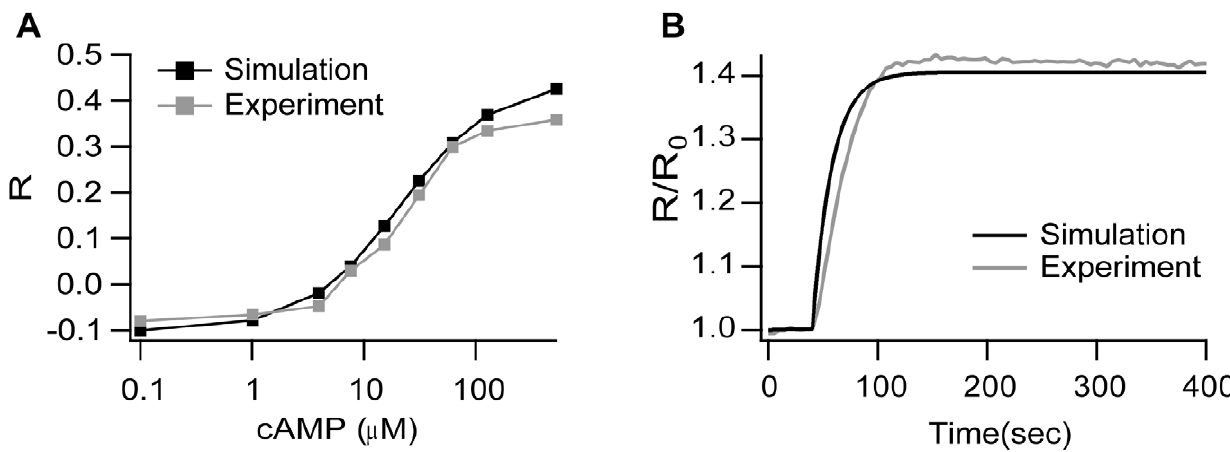
Figure 2. FRET signal as a function of cAMP concentration. (A) Steady state dose-response simulation (black) and experimental (gray) curves show excellent agreement. Ordinates are background-subtracted FRET emission ratio changes, D R, measured relative to the prestimulus ratio R(0). (B) Time course of simulated and experimental FRET signal shows excellent agreement. FRET ratio trace obtained by delivery of 30 m M cAMP to cell under whole-cell recording conditions. All experiments were performed in HeLa cells transfected with H30 (acquisition conditions: 1 frame/5 s). The microscope was equipped with a CCD camera (Sensicam QE; PCO), a software-controlled monochromator (Polychrome IV; TILL Photonics), and a beam-splitter optical device (Multispec Microimager; Optical